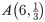
Comparison of the fix strategies with different expected utilities in a decision game of G of 24.The options are A(6,13), B(6, 0.3), and C(4, 0.5), denoted by the black square, red circle, and blue diamond, respectively. The PMF and CDF curves are shown in (A) and (B), respectively. Between A and B, where ΔuΔp > 0, it is found that choosing A is dominant because PcomA > PcomB in the whole t range shown in (B). Between A and C, which have the same expected utility, the two curves interlace at tint near 12. For t < tint, A is preferred, whereas for t > tint, B is preferred. Between B and C, which have different expected utilities, the two curves interlace at tint near 10. For t < tint, B is preferred, whereas for t > tint, C is preferred. Therefore, between the options in which ΔuΔp < 0, the preferred option becomes t dependent.